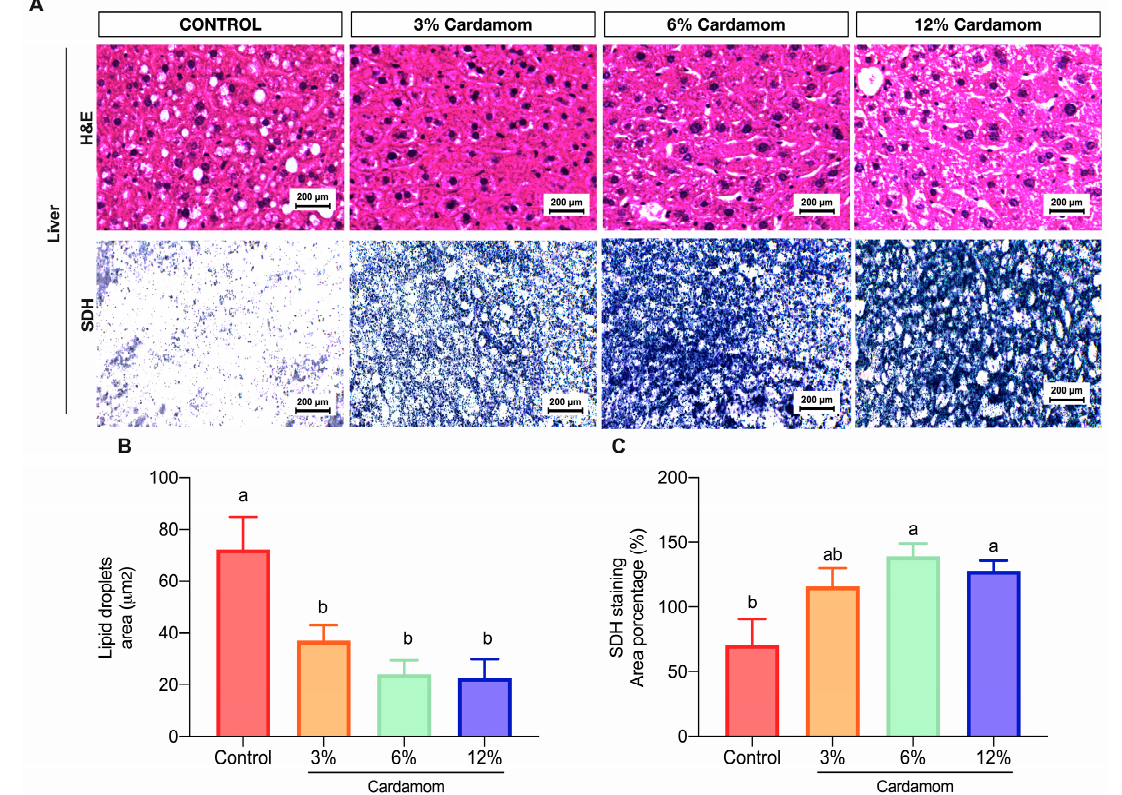
Figure 5. Liver morphology and hepatic SDH activity of mice fed a control diet or a diet containing 3%, 6% or 12% of Elettaria cardamomum (EC). ( A ) representative photomicrographs were taken from each section at 40 × of hematoxylin and eosin (H&E) and succinate dehydrogenase (SDH) staining in the liver; ( B ) lipid droplets’ mean area; and ( C ) SDH densitometry as (%) of liver sections of mice fed a control diet or a diet containing 3%, 6% or 12% EC. Results are presented as the mean ± S.E.M., n = 8 mice per group. The differences were considered statistically significant when p < 0.05. Mean values with different lowercase letters show statistical differences between each other. Digital photographs were taken from each section at 40 ×.